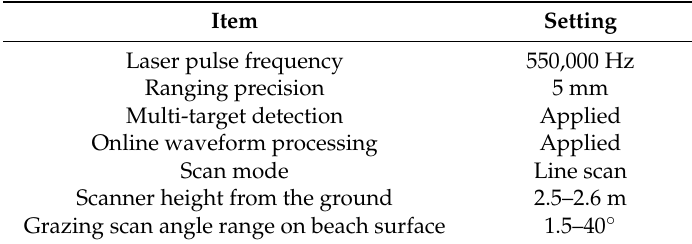
Figure 1. ( a ) Southern California study area and example cobble exposures of ( b ) dense upper-beach cobble berm, and ( c ) mid-beach cobble patches.